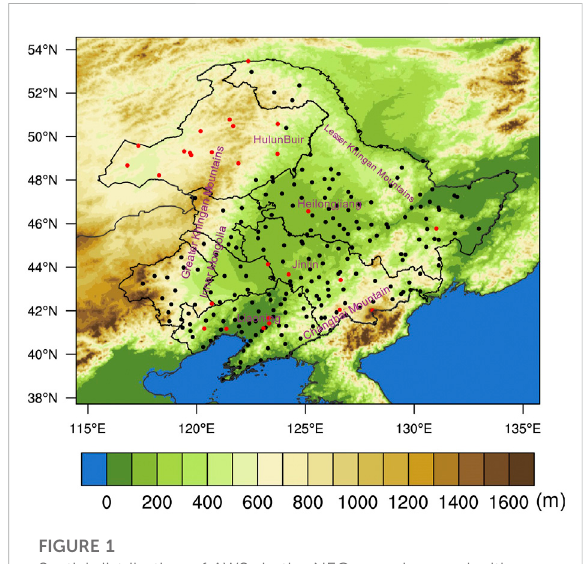
FIGURE 1 Spatial distribution of AWSs in the NEC, superimposed